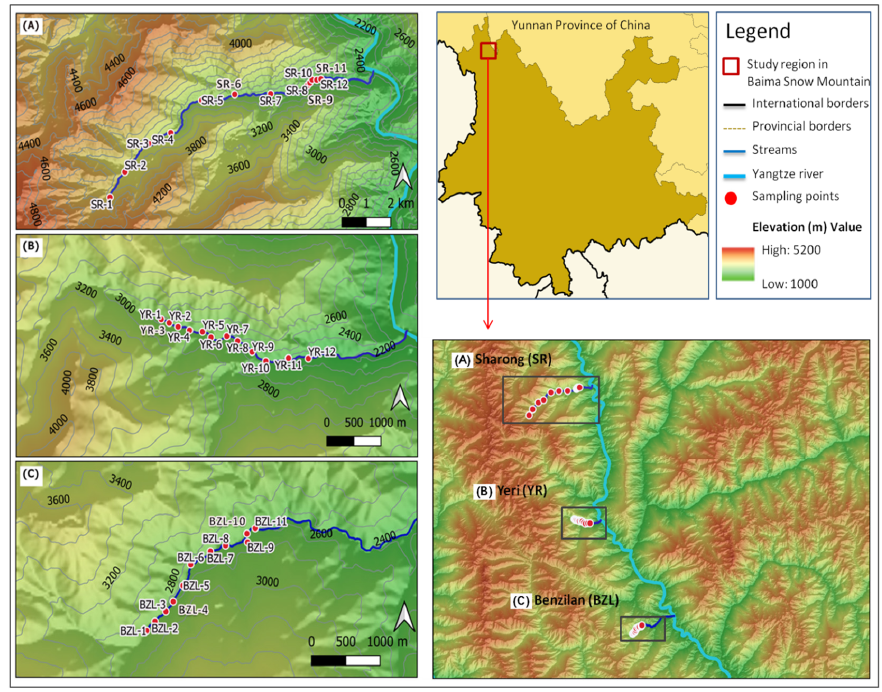
Figure 1. Map of the study region and the distribution of sampling sites ( n = 35) of the three streams in Baima Snow Mountain, northwest Yunnan, China. ( A ) Sharong, ( B ) Yeri, and ( C ) Benzilan. From September to October 2017, a total of 35 sites located in the dry-hot valley en- vironment of the Baima Snow Mountain were sampled. The sites were distributed in three tributary streams of the Yangtze River, namely, Benzilan (BZL), Sharong (SR), and Yeri (YR). These watercourses are small (maximum width of 4.5 m) and shallow, with beds composed of pebbles. Following the elevation gradient along the streams, different vegetation types covered the areas around the sample points. The sites located more up- stream were relatively free from human activities, being situated far from settlements, while small-scale agricultural activities took place around the middle and downstream sites. Six sampling sites of the SR stream were located within the dry-hot valley envi- ronment with extremely low vegetation cover. Macroinvertebrate samples were collected by using a Surber net (30 × 30 cm, 500 µm, mesh size), and the materials left on the sieve were manually hand-picked and stored in 95% ethanol. At each site, five replicates were taken in order to cover a variety of habitat types. All specimens were identified and classified to genera and possibly to morphospecies level using Morse et al. [31], Dudgeon [32], and literature in the lab. For each stream site, physicochemical variables including water temperature (WT), conductivity (Cond), dissolved oxygen (DO), total dissolved solids (TDS), hydrogen ion concentration (pH), and oxidation reduction potential (ORP) were measured in situ with a multi-parameter probe (YSI Professional plus, United States) during the macroinvertebrate sampling. We also recorded the flow rate (Flow-v) using a Flow Globe FP101 (Global Water) turbidity (Turb) with a turbidity meter (SGZ–200BA, China), and the width of each stream was measured using a tape. The ele- vation and geographical coordinates of sampling sites were retrieved with a GPS unit (Garmin eTrex20, China). For the remaining variables, water samples were collected in pre-cleaned and polyethylene bottles and acidulated to a pH < 2 by adding sulfuric acid in the field. In the laboratory, a segmented flow analyzer (Skalar San++, the Netherlands) was used to quantify the concentration gradients of total phosphorus (TP), orthophos-